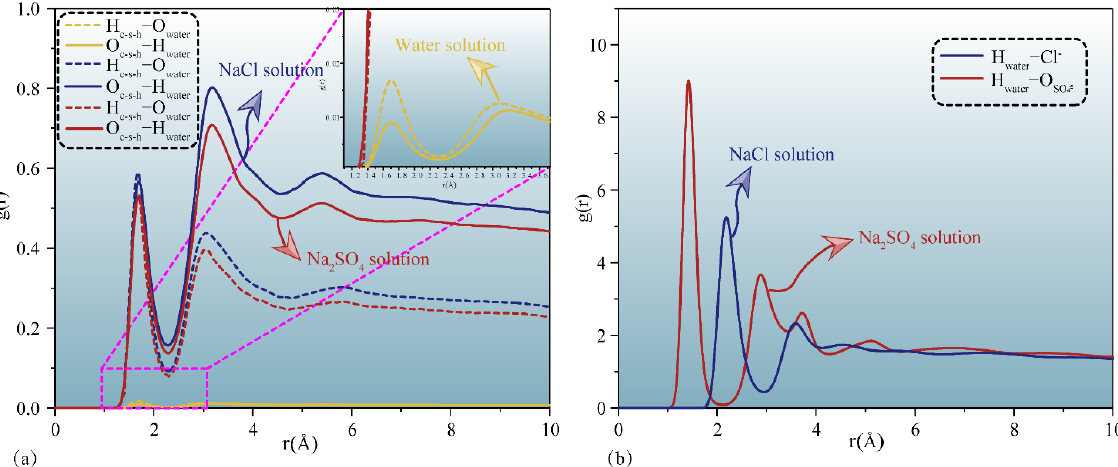
Figure 3. Radial distribution function between atoms from the solution and C-S-H matrix: ( a ) hydroxy from C-S-H versus hydroxy from different solutions, ( b ) hydrogen atoms from eroded solution versus eroded ions.